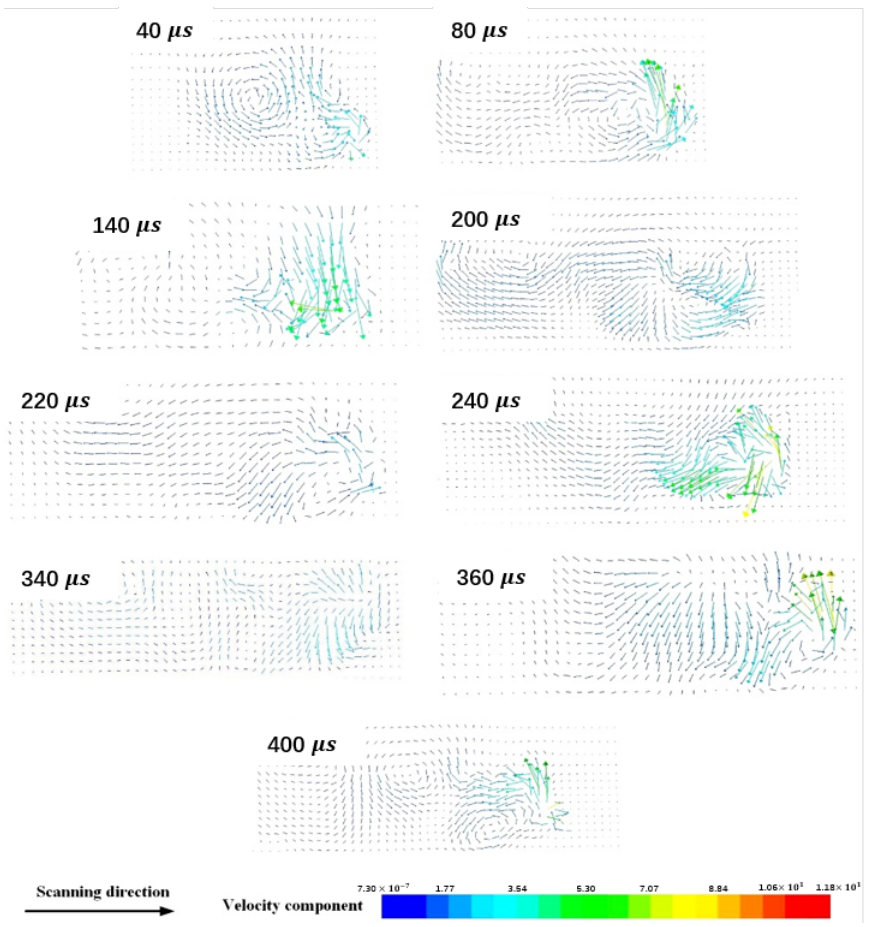
Figure 14. Change in fluid flow in the melt pool of one single-track scanning in XZ section with time.